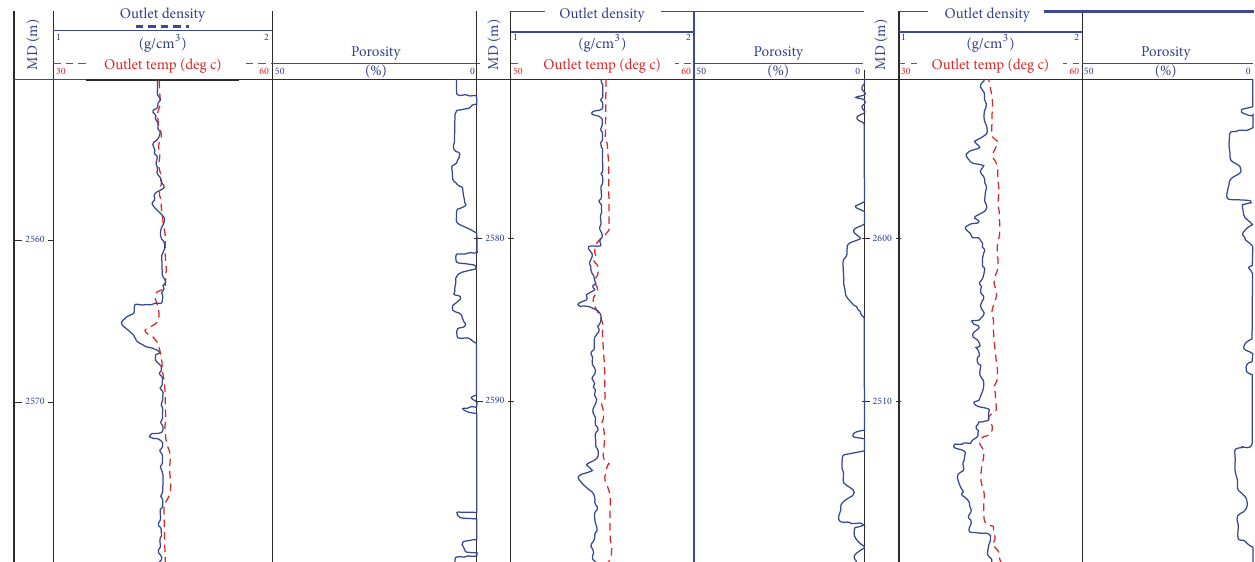
Figure 8: Changes in well log curves in gas zones, PL